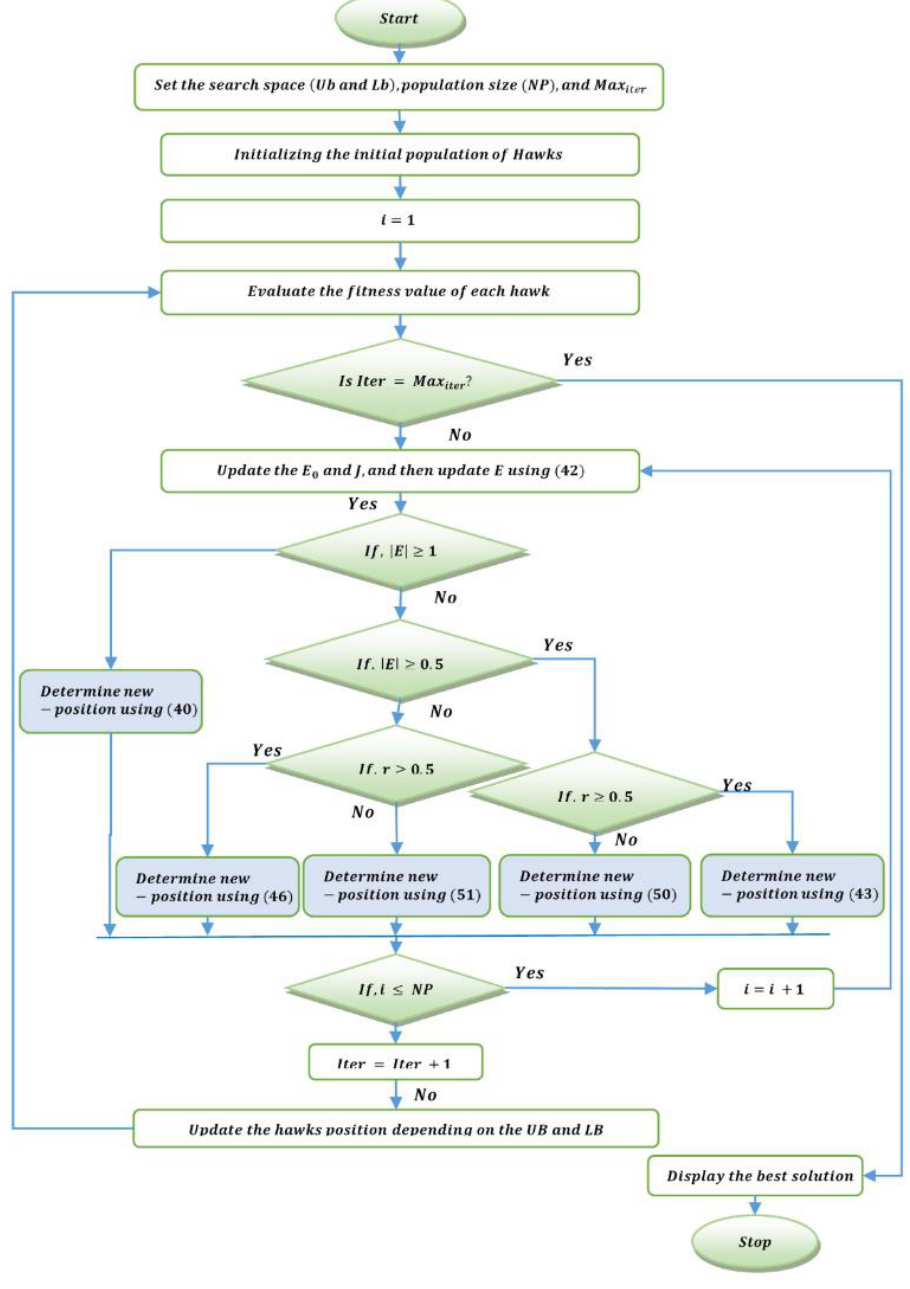
Figure 2. Flowchart of HHO algorithm.